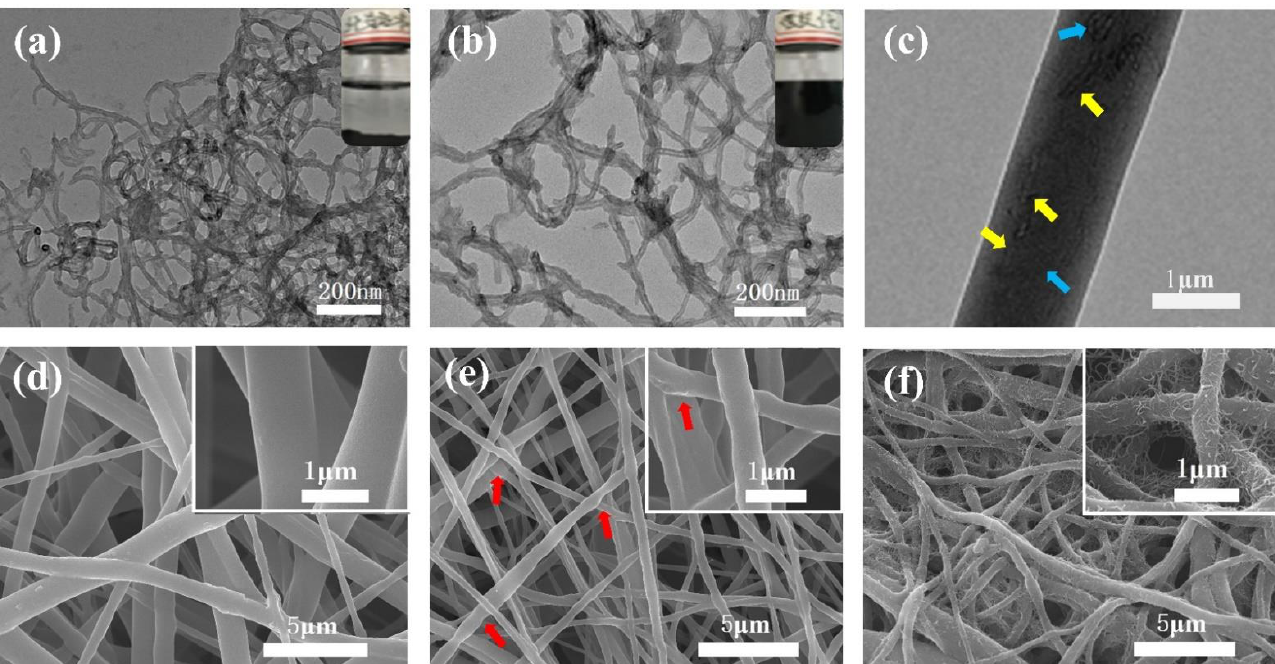
Figure 2. Morphologies of the composites. ( a – c ) TEM images of MWCNTs ( a ), a-MWCNTs ( b ) and TMFM 201 ( c ). The insets of ( a , b ) are MWCNTs and a-MWCNTs dispersion, respectively. ( d – f ) SEM images of pure TFM ( d ), TMFM 202 ( e ) and TMMFM-5 ( f ).